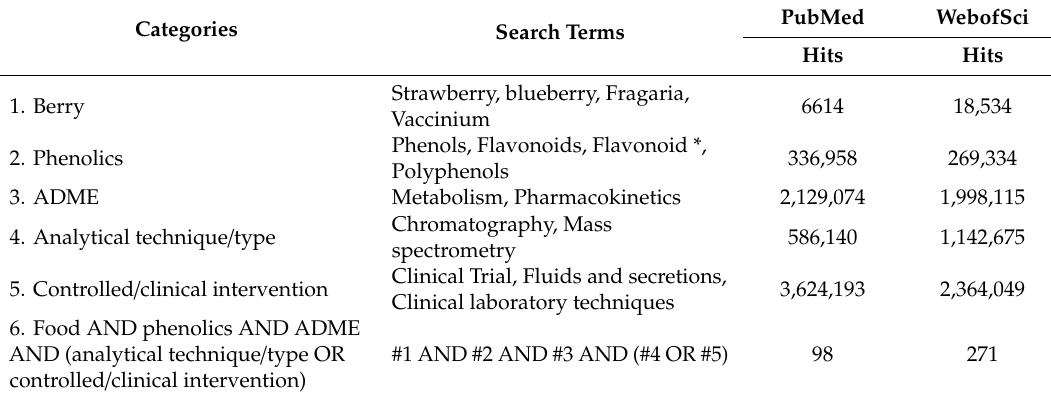
Table 1. Literature review search